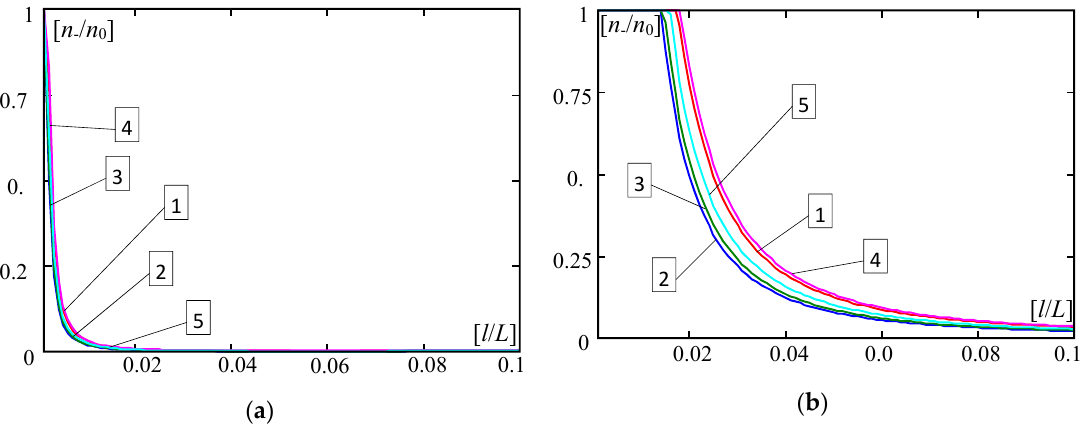
Figure 6. Values of ratios n _ / n 0 versus l / L ( E ” / E ’ = 0.3, d / L = 0.001, m = 1). ( a ) For κ = 0.0001; ( b ) For κ = 0.000001. (1— γ by (28) 1 , 2— γ by (28) 2 , 3— γ by (28) 3 , 4— γ by (28) 4 , 5— γ by (29)).